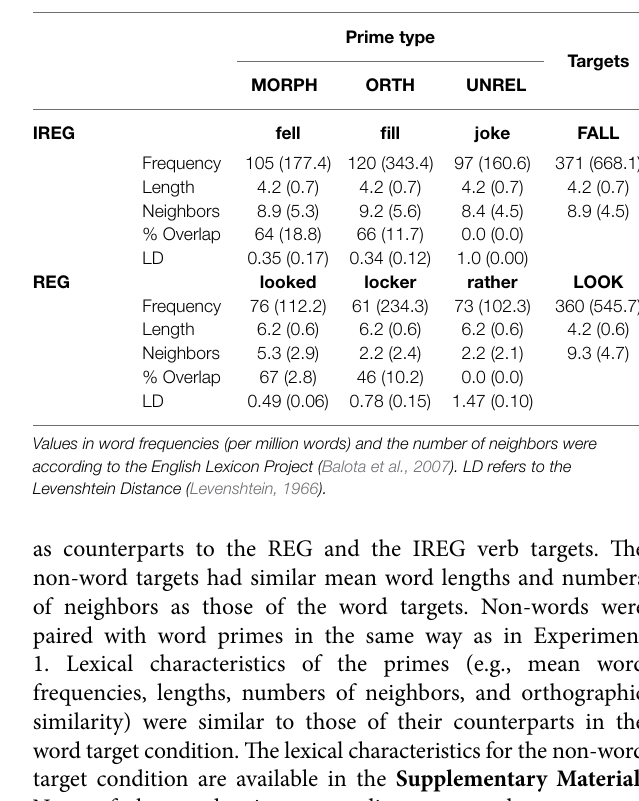
TABLE 3 | Lexical characteristics and examples of prime-target pairs used in Experiment